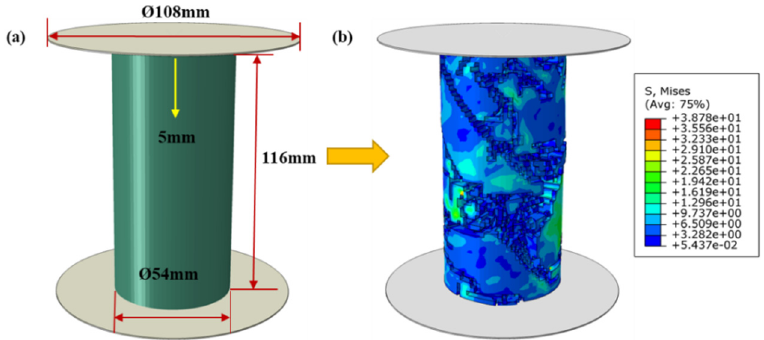
Figure 1. The 3D modeling of uniaxial compression test of sandstone: ( a ) The finite element (FE) model consists of a cylinder and two thin disks. The highlighted arrow represents that the upper disk is subjected to a downward displacement load of 5 mm. ( b ) Contour plot of uniaxial compression damage of